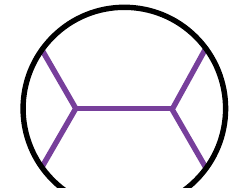
Figure 7. Exchange Witten diagram contributing to (cid:12) 2 , after integration in R d d x